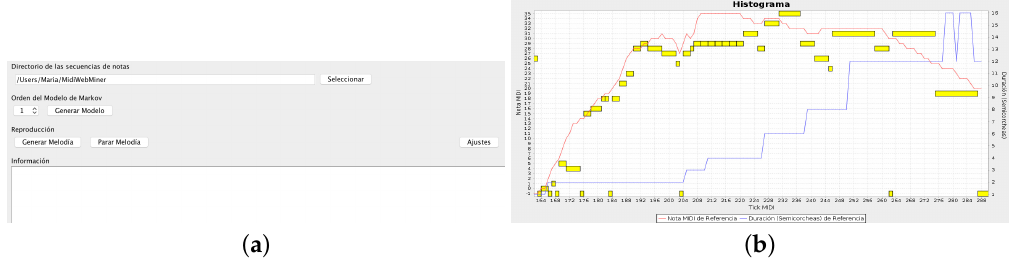
Figure 7. ( a ) Capture of the screen while the user is composing a melodic line; ( b ) Caption of the main